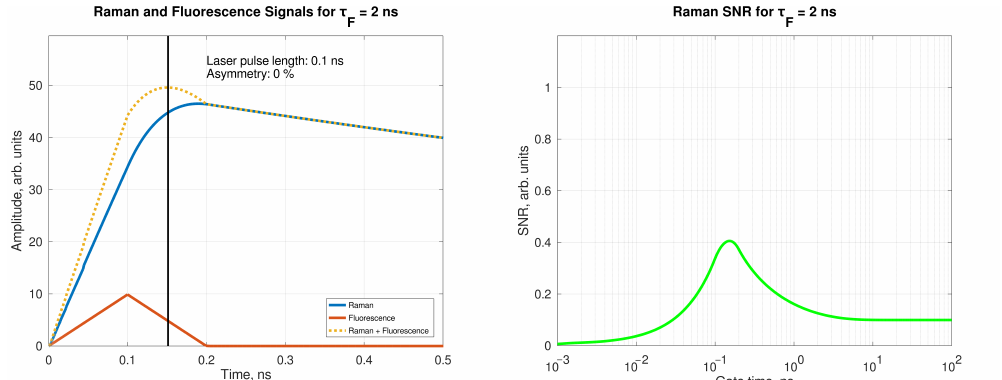
Figure 3. The Raman, fluorescence and total (Raman + fluorescence) signals as a function of time ( left ) and the Raman signal-to-noise ratio (RSN) as a function of the gating time. The black line in the left plot represents the gating time at which the best RSN is obtained, i.e., the abscissa of the maximum in the ( right )